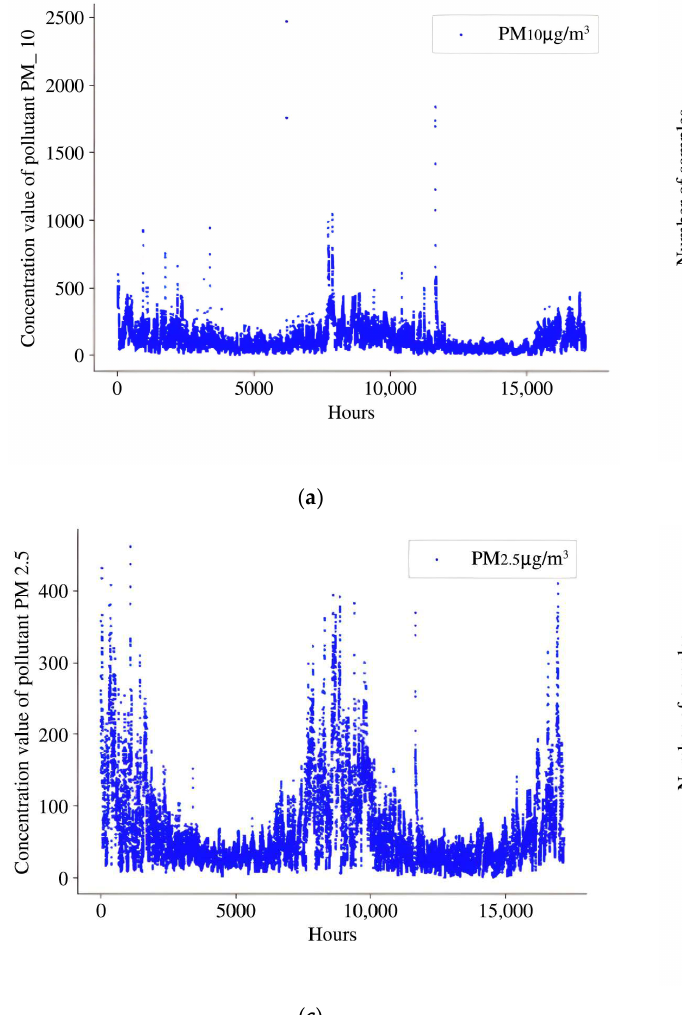
Table 5. An example of air pollutant grades at the Central Square Station of the Xi’an Xin Cheng district in Xi’an city from 2018 to 2020 after redivision classification.